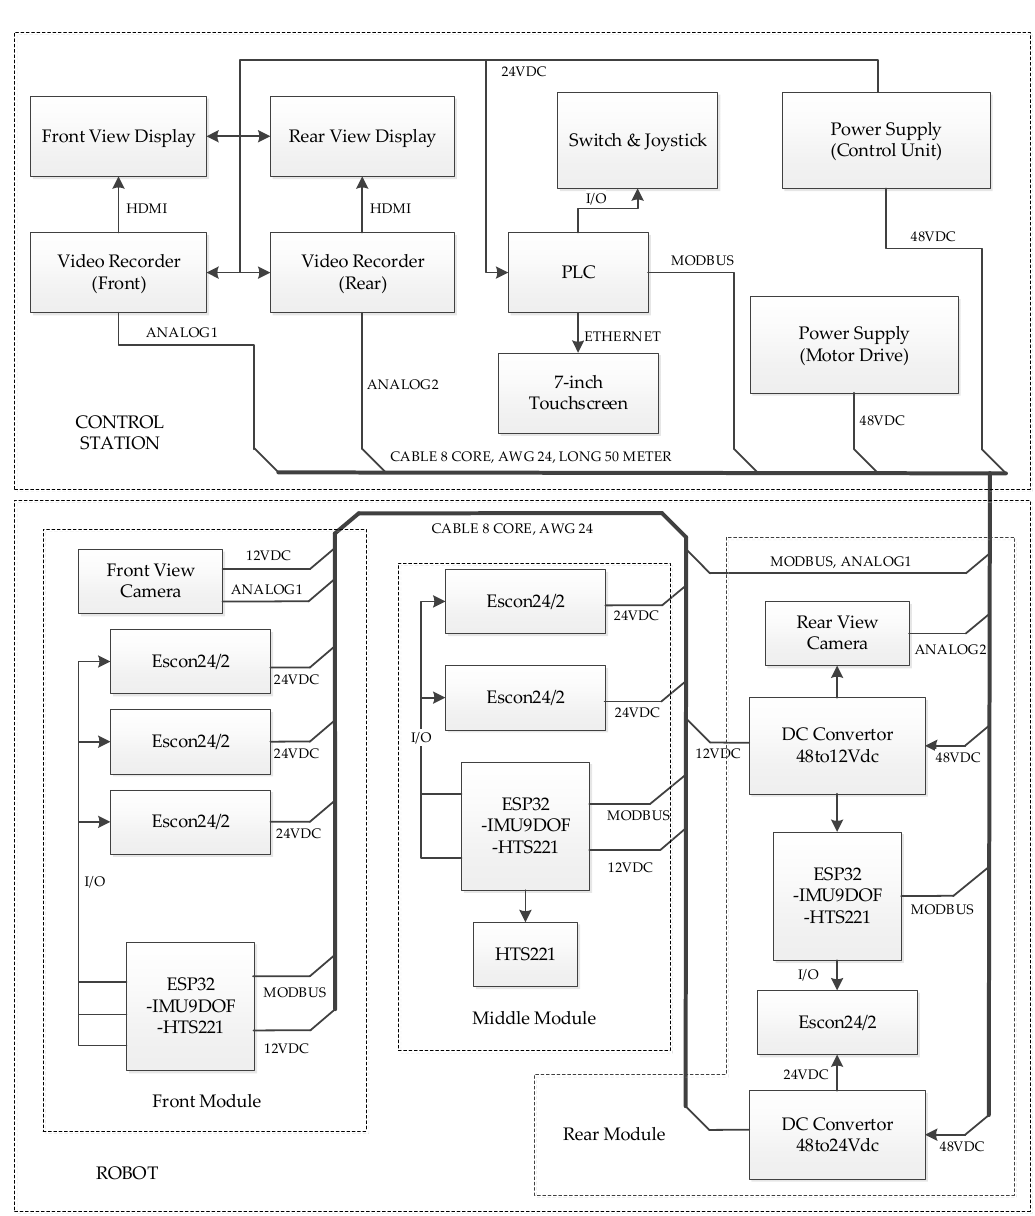
Figure 10. The schematics of the robot’s electrical diagram.